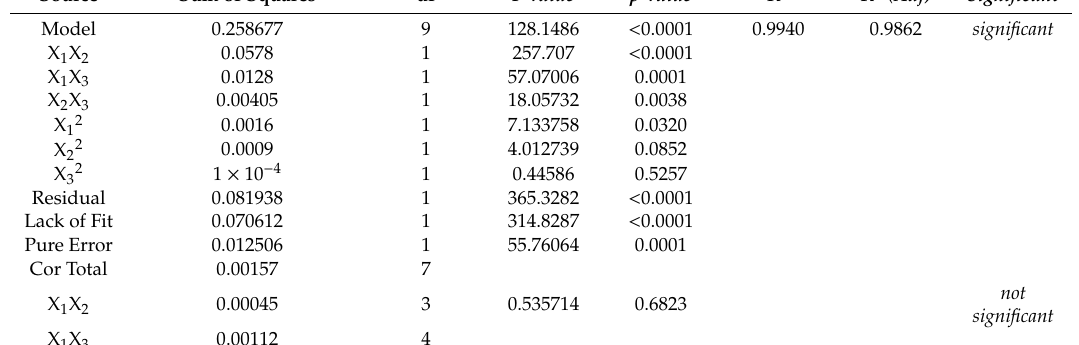
Table 2. ANOVA for the fitted secondary order curve for HIN content.